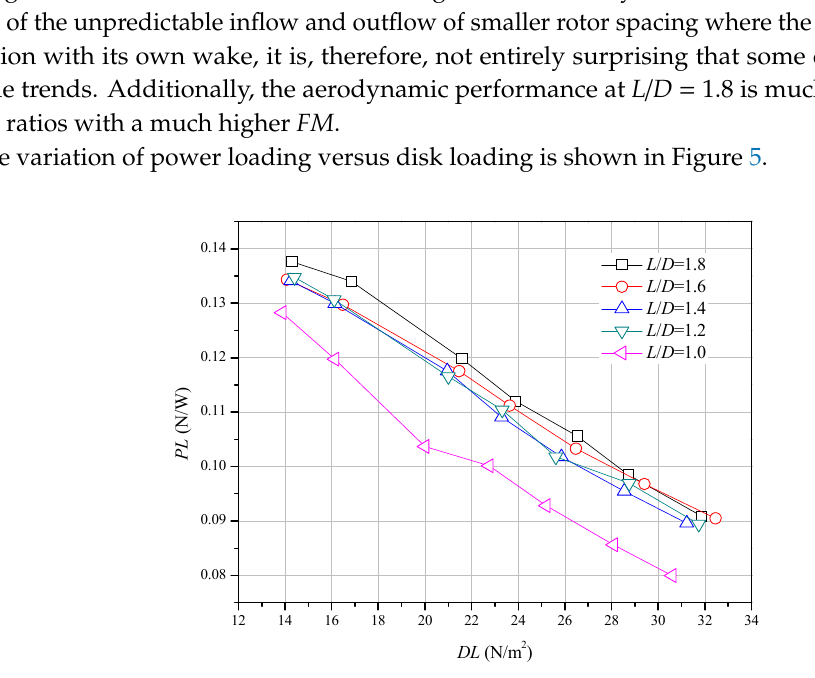
Figure 5. Variation of power loading and disk loading.